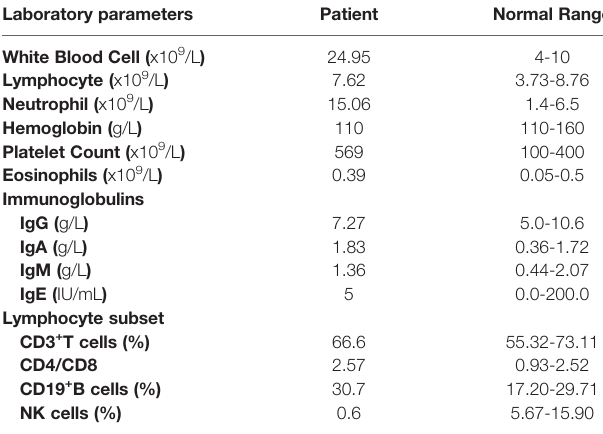
TABLE 1 | Laboratory parameters of the patient.